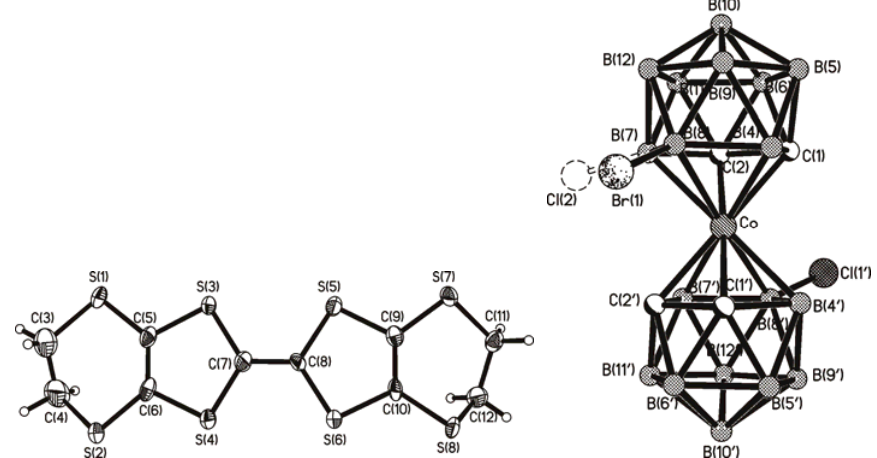
Figure 5. Atom designations in (BEDT-TTF)[8,8'-Br The dashed line denotes position of the atom Cl(2) populated by 25%, the position of the atom Br(1) is populated by